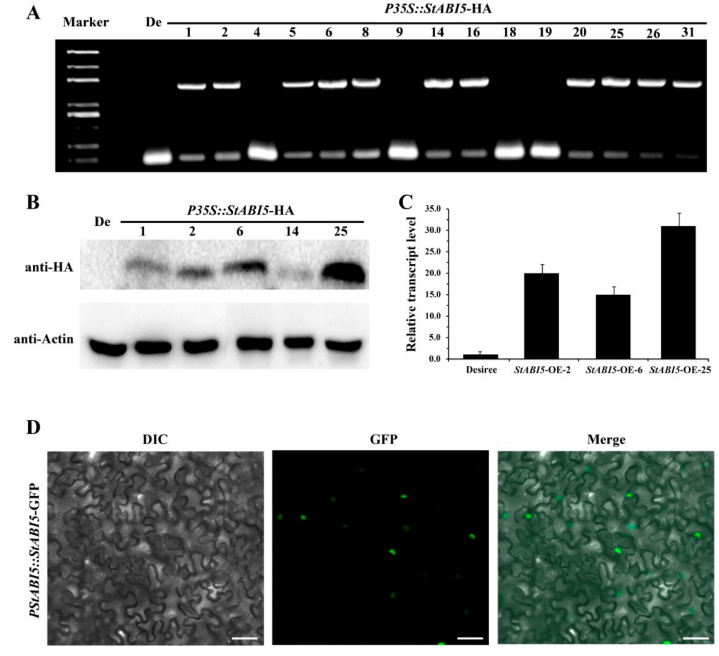
Figure 2. Identification and subcellular localization of StABI5 transgenic potatoes. ( A ) Identification of StABI5 transgenic potato lines by leaf PCR. The amplified PCR product was 1547 bp when using primers P35S F and StABI5 R. De: Desiree. ( B ) Western blot analysis of StABI5 protein expression in StABI5 transgenic potato lines. ( C ) The transcription level of StABI5 in StABI5 transgenic potato lines obtained by qRT-PCR. StACTIN58 was used as an internal control. ( D ) Subcellular localization of StABI5 in tobacco ( Nicotiana tabacum ). Tobacco transiently expressed Agrobacterium strain containing the PStABI5 :: StABI5 - GFP vector, and the localization of GFP was observed by laser confocal microscopy. Bars, 50 µ